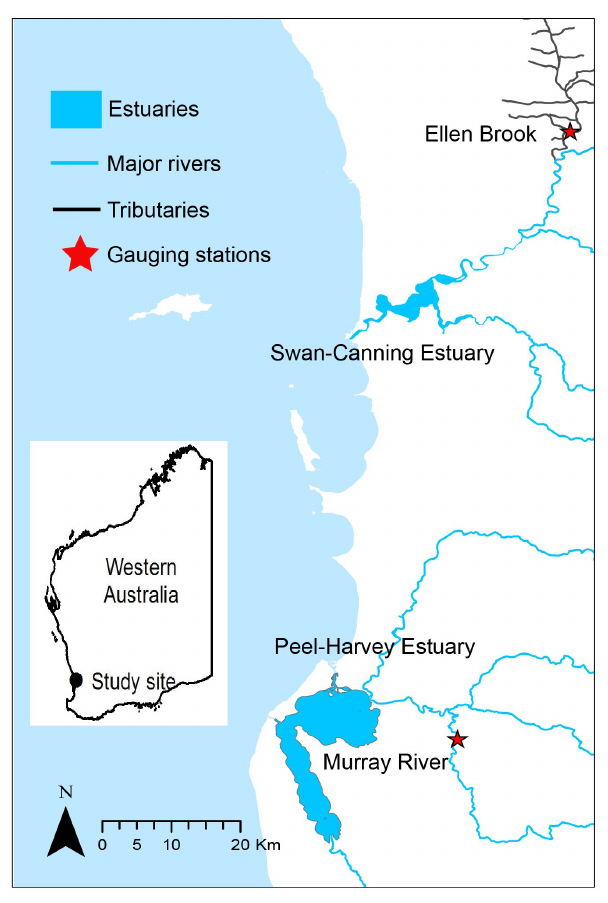
Figure 2. The location of Ellen Brook and Murray River.